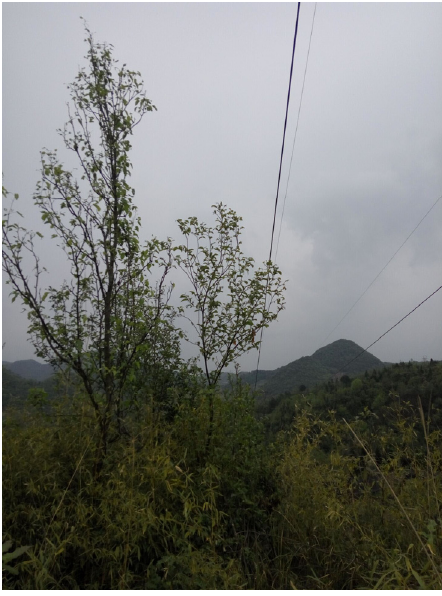
Figure 12. Diagram of an obstacle within the Power Line Corridor.